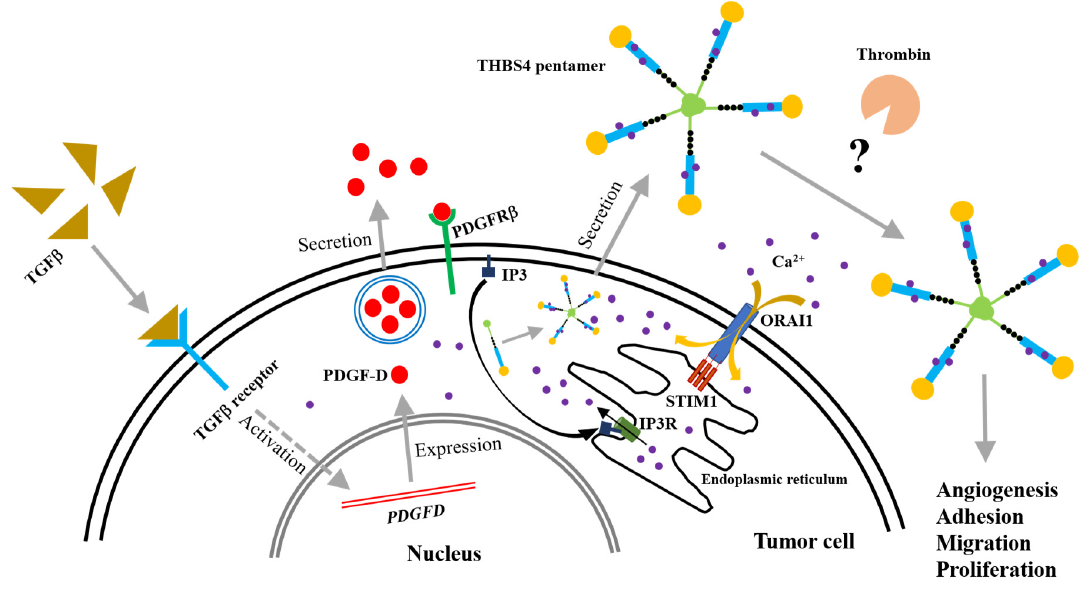
Figure 7. Model representing possible molecular pathways by which PDGFR β and THBS4 cause the development of colorectal cancer.